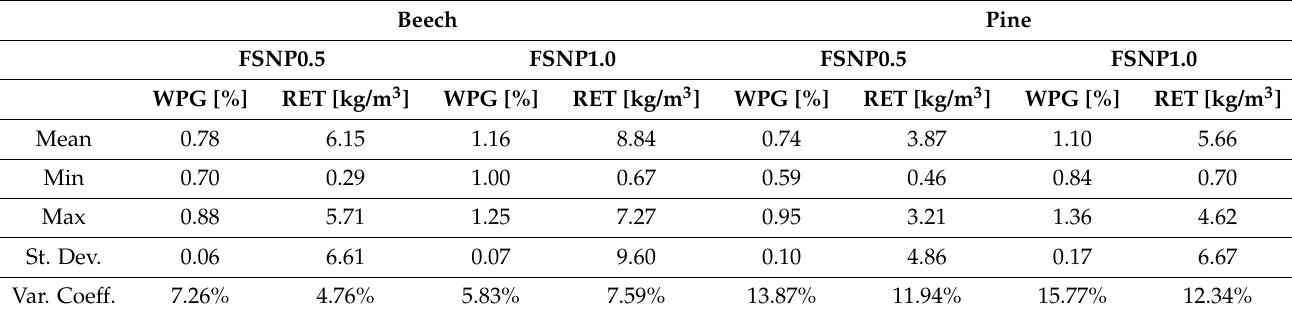
Table 1. WPG and RET values of FSNP-modified beech and Scots pine samples.